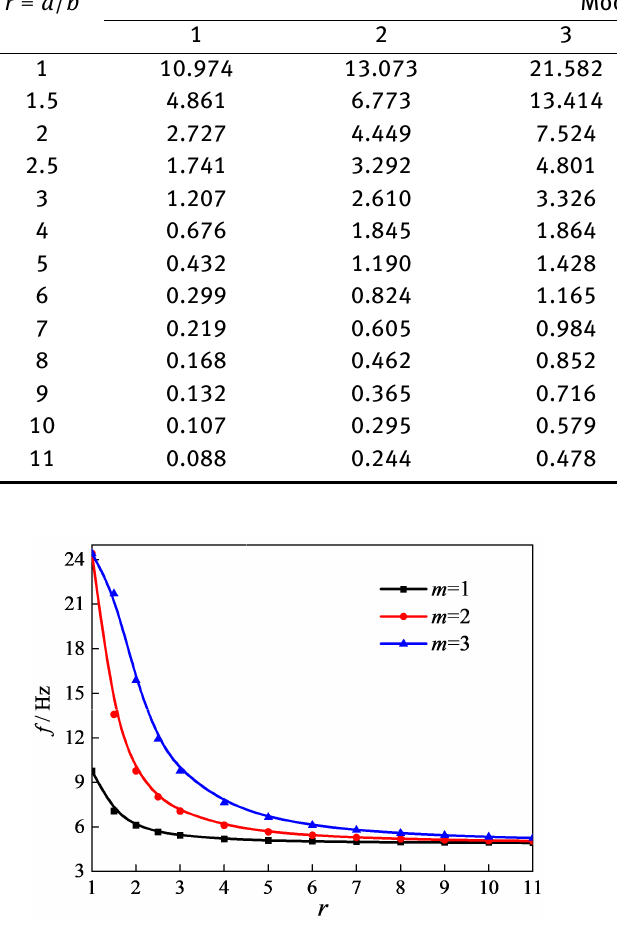
Figure 7: The velocity response of point (0.5,0.5) with C-C-C-C bound- ary condition